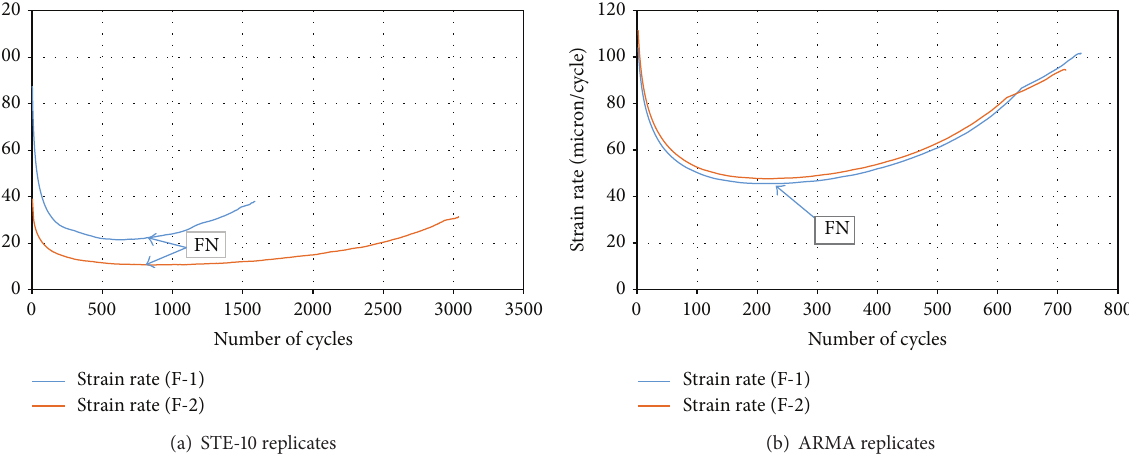
Figure 5: Permanent strain rate curves.